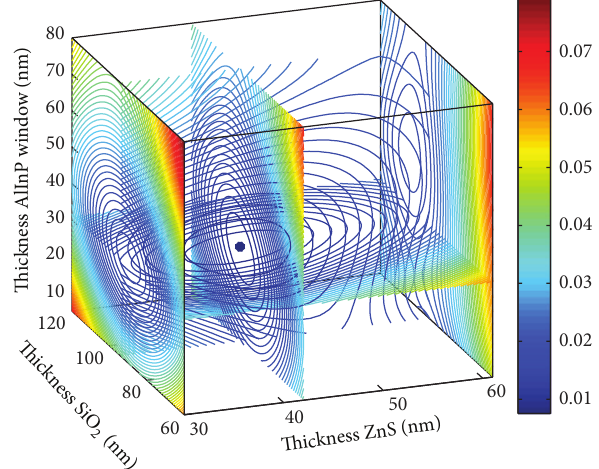
Figure 2: SiO 2 /ZnS ARC 𝑅 𝑒 versus films